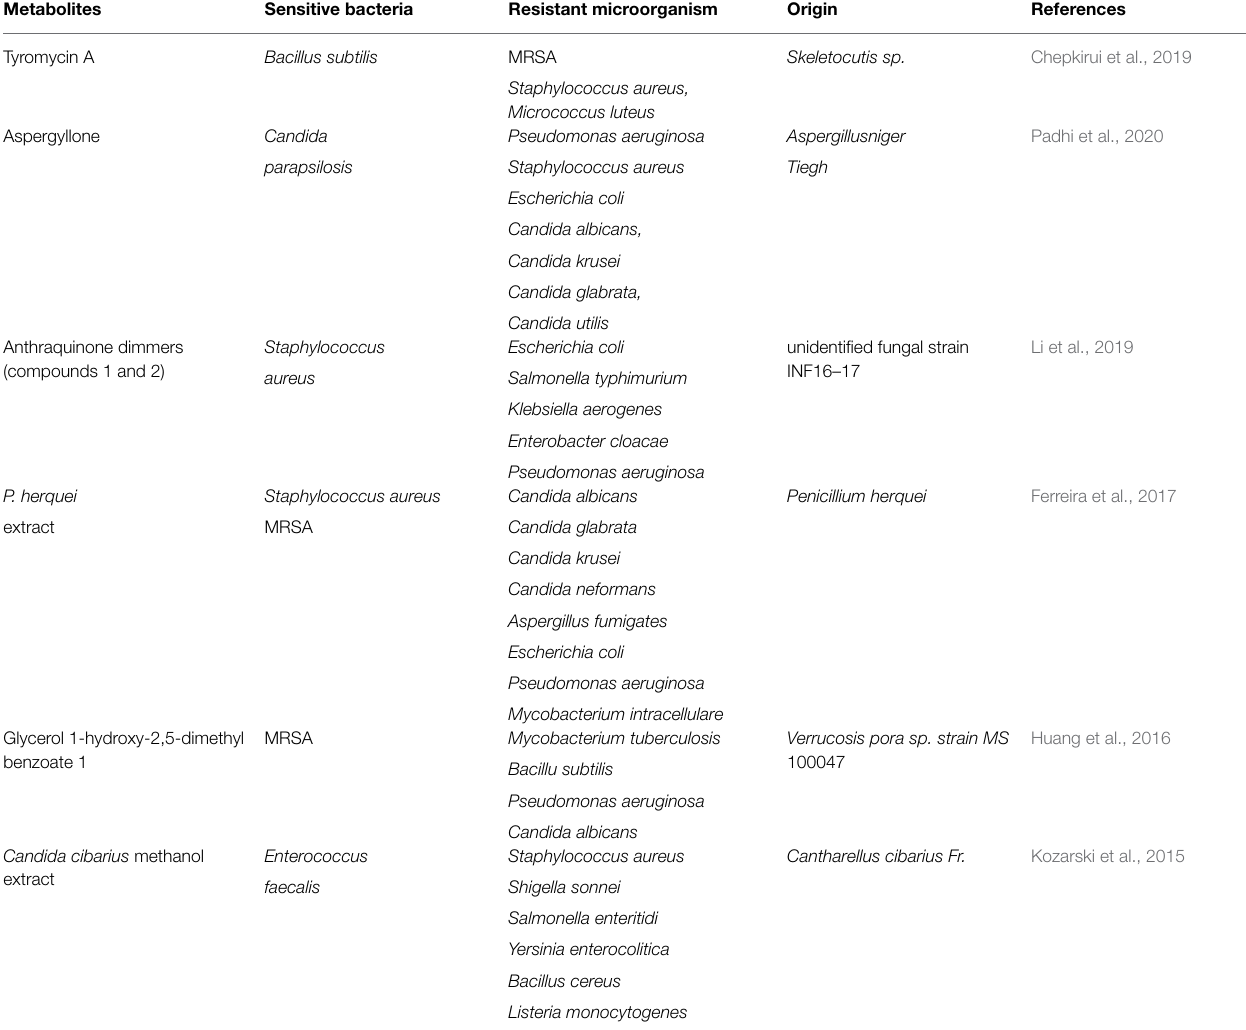
TABLE 2 | Selective antimicrobial activity of bacterial secondary